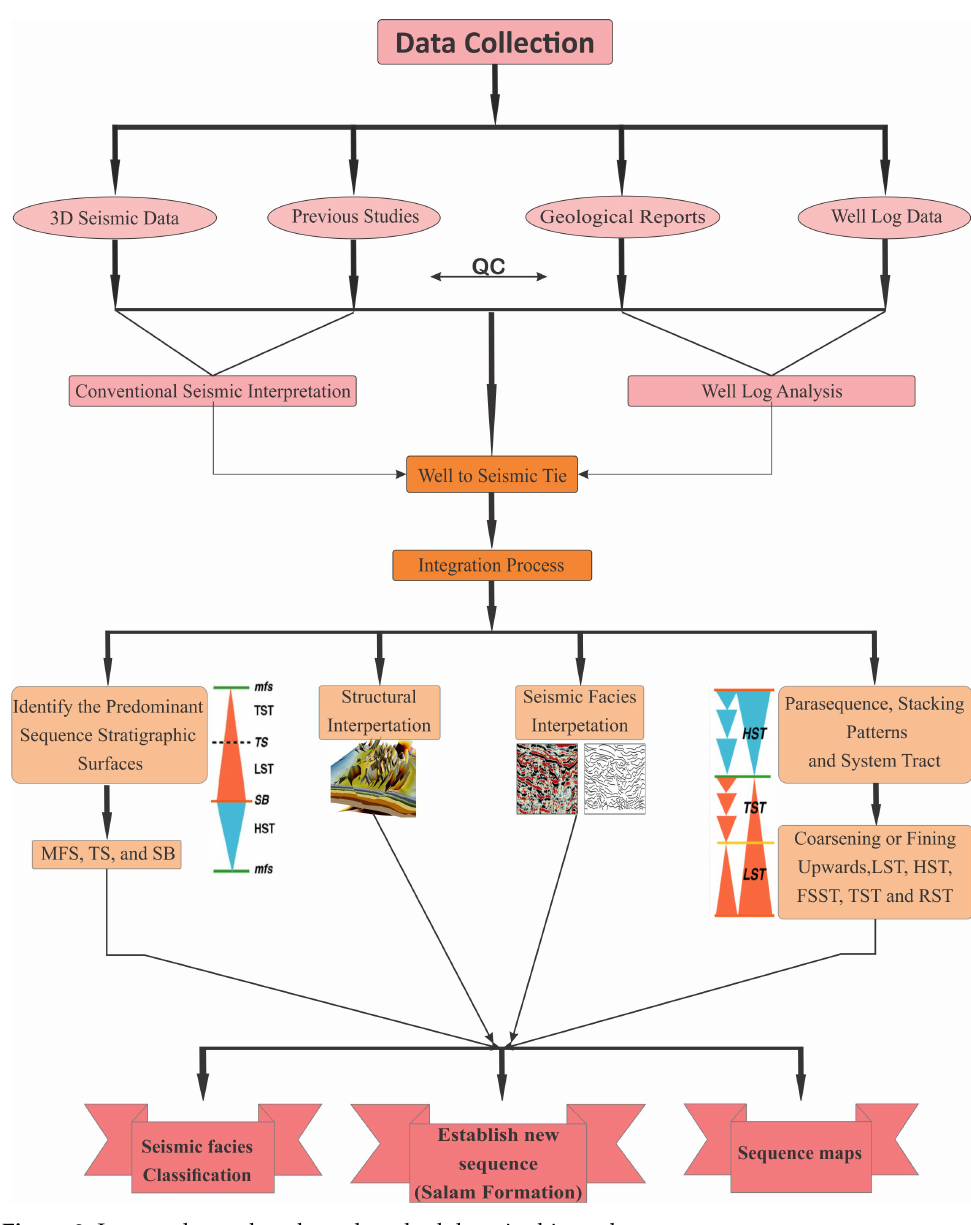
Figure 2. Layout shows the adopted methodology in this